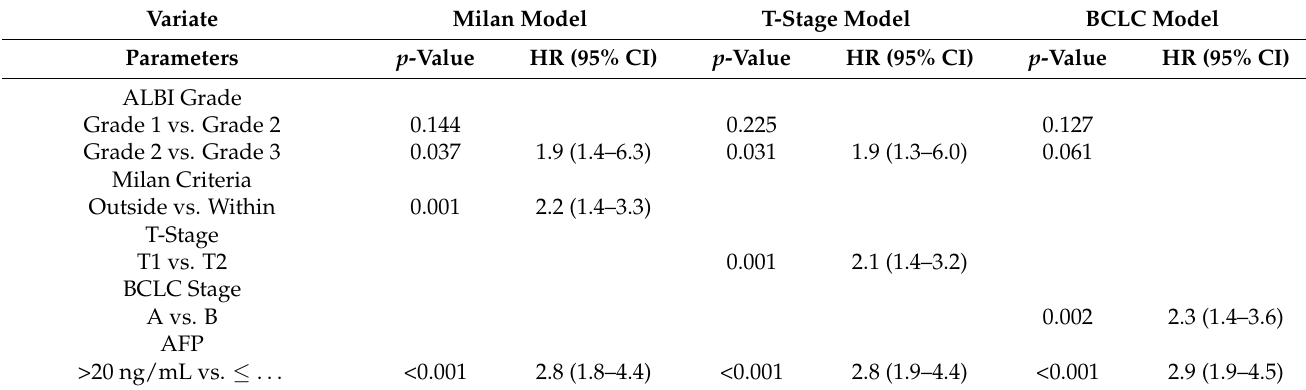
Table 4. Multivariate analysis of time to progression by ALBI